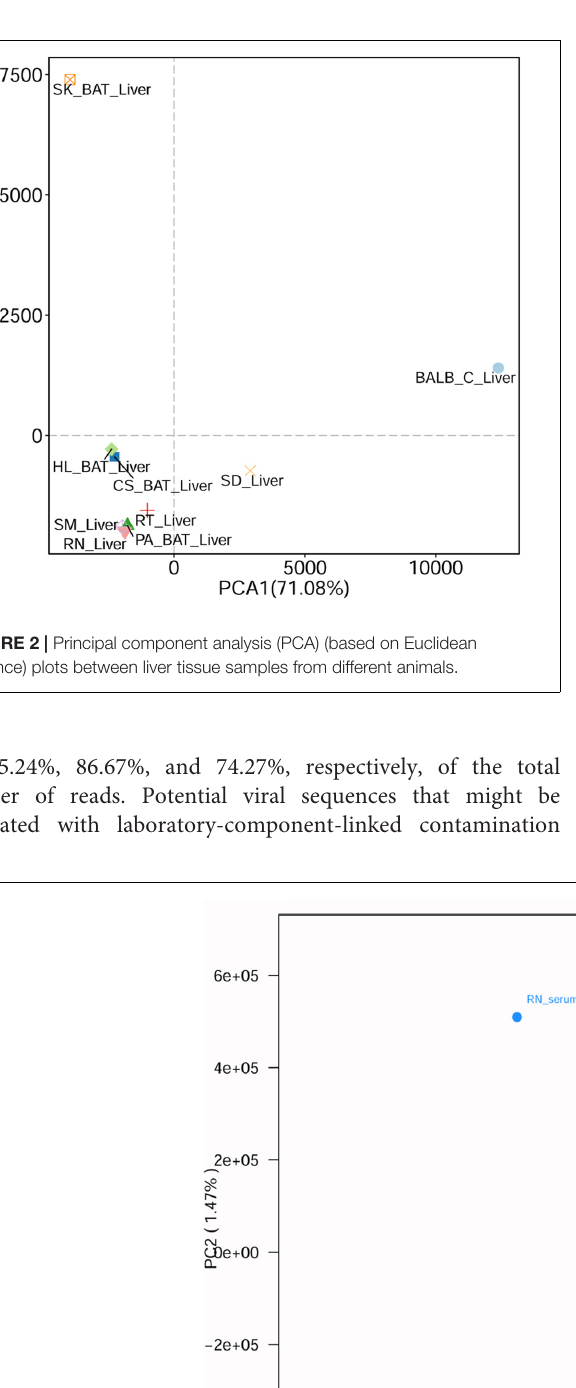
FIGURE 3 | Principal component analysis (PCA) (based on Euclidean distance) plots between liver tissue and serum samples from R. norvegicus .